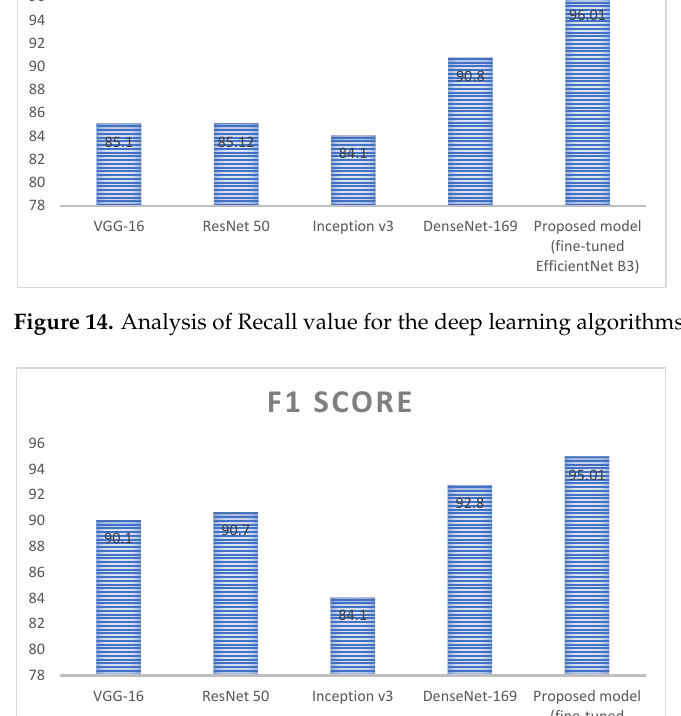
Table 8. F1 score calculation for detection of monkeypox disease detection.